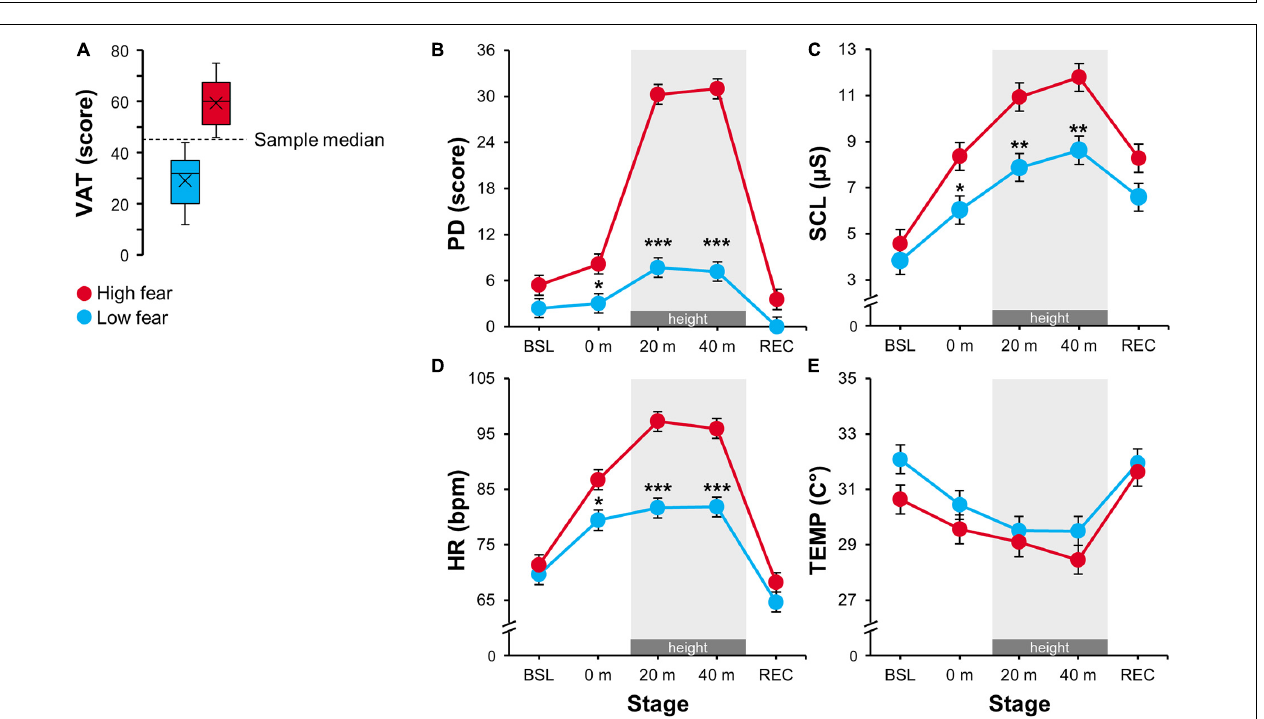
FIGURE 1 | The schematic depiction of the experimental set up (left) and the main VR simulation (right). Panels (A–D) depict the virtual elevator and the participant’s view at the height of 0, 20, and 40 m, respectively.